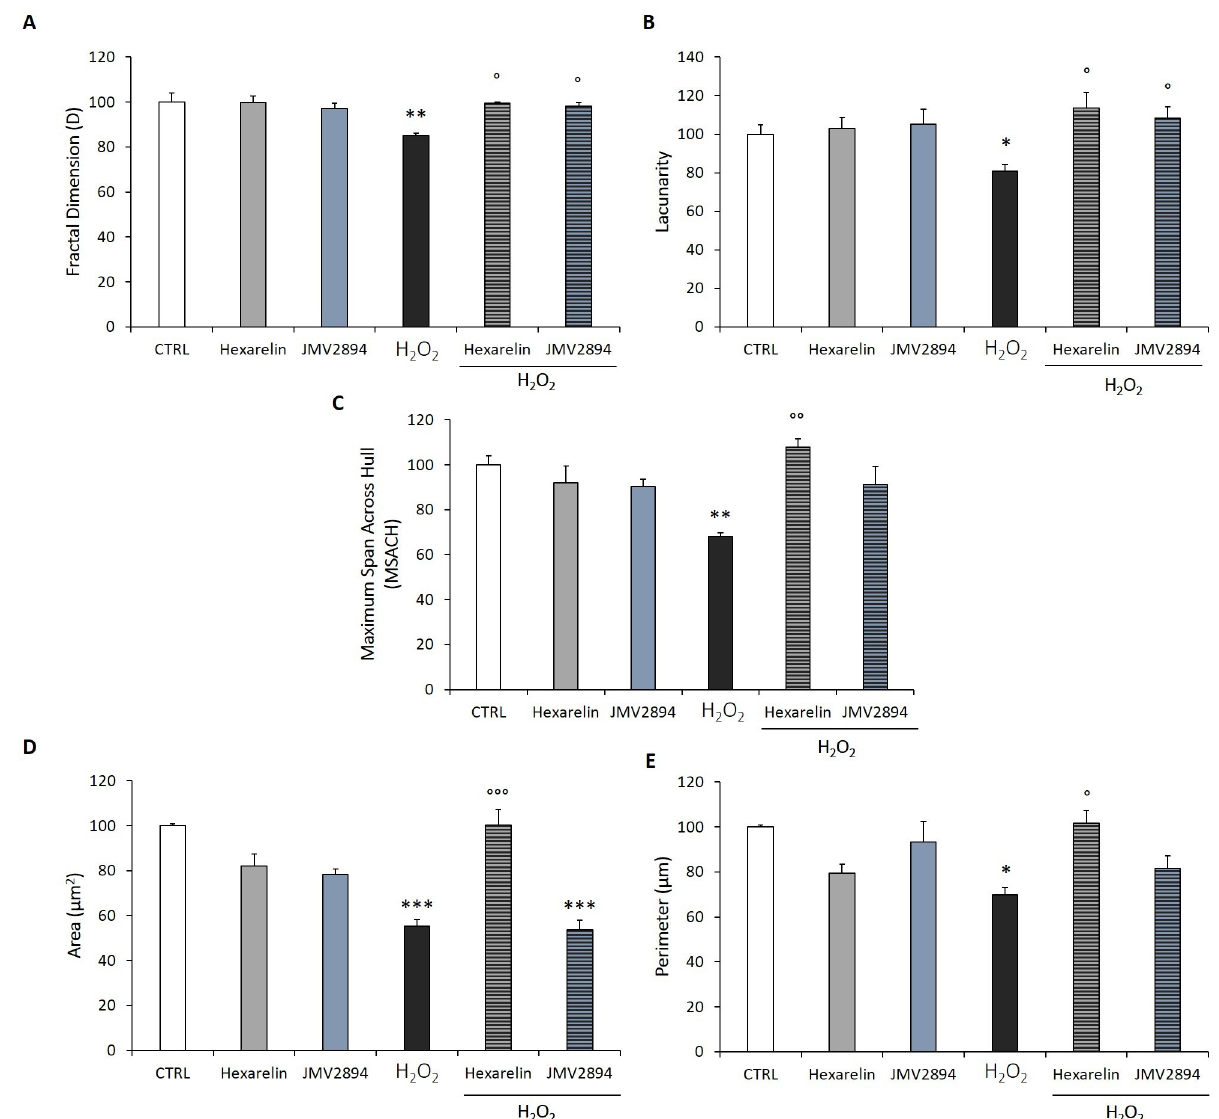
Figure 4. GHS modulation of morphological changes in SH-SY5Y SOD1 G93A cells induced by H 2 O 2 treatment. Numeric representation of: ( A ) Fractal dimension, ( B ) lacunarity, ( C ) maximum span across the convex hull, ( D ) area, and ( E ) perimeter in SH-SY5Y SOD1 G93A cells treated for 24 h with 150 µM H 2 O 2 alone or in combination with GHS. Total number of cells analyzed for each condition = 10. Data are expressed as mean ± SEM. Statistical significance: * p < 0.05, ** p < 0.01, *** p < 0.001 vs. CTRL; ° p < 0.05, °° p < 0.01, °°° p < 0.001 vs. H 2 O 2 .